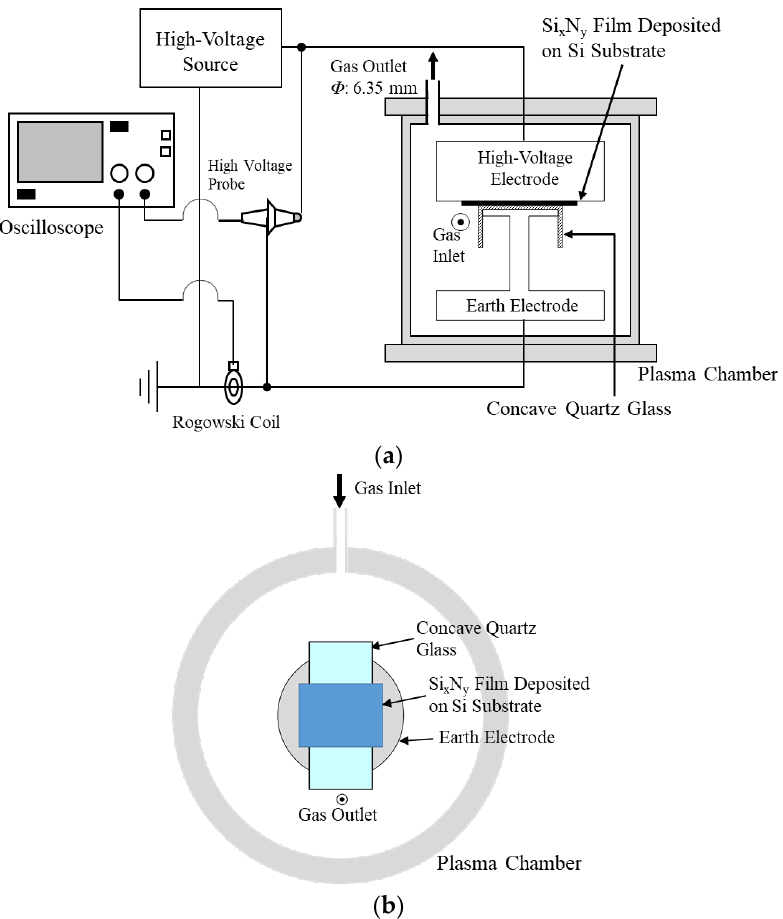
Figure 1. Schematic of surface-discharge-plasma etching system: ( a ) Plasma etching system; ( b ) gas- supply structure in plasma chamber.